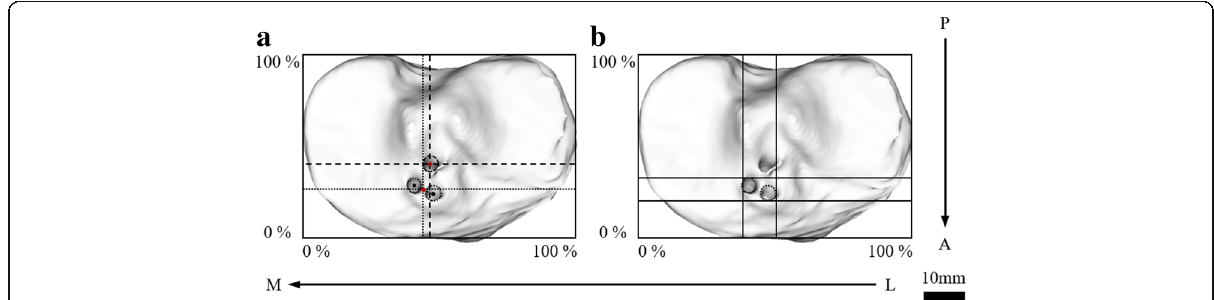
Fig. 3 a Measurement of the center location of the tibial tunnel footprint. The locations of the centers of the anterior and the posterior tunnels footprints were measured as percentages of the anterior – posterior and the medial – lateral distances on the tibial plateau from the anterior and the medial borders, respectively. b Measurement of the location of the anterior, posterior, medial, and lateral edges of the anterior tunnels footprints. The locations of the anterior and posterior edges of the footprint were measured as percentages of the anterior – posterior distance on the tibial plateau, while those of the medial and lateral edges were measured as percentages of the medial – lateral distance on the plateau, respectively. M : medial, L : lateral, A : anterior, P :